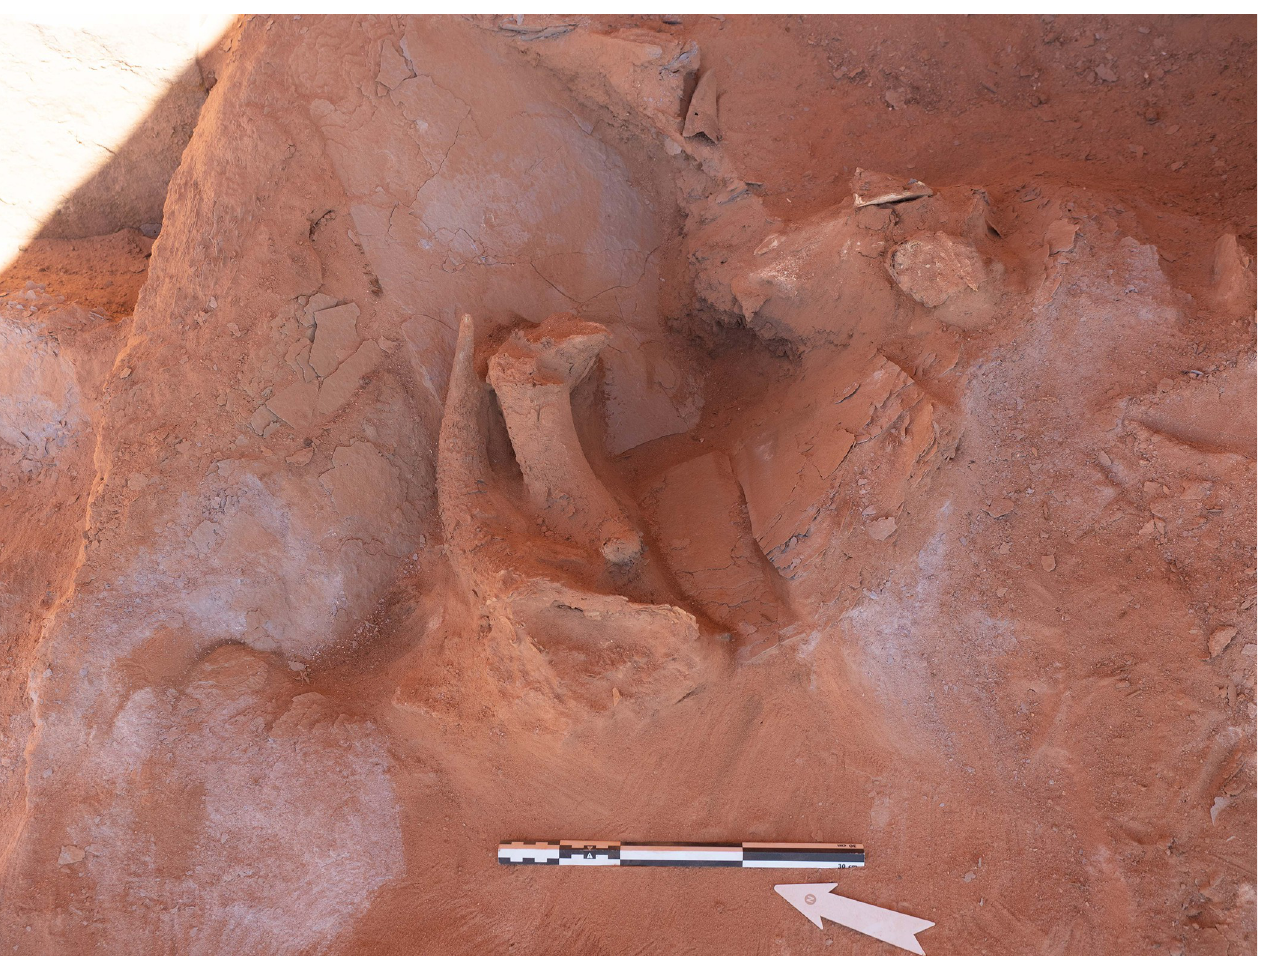
Fig 13. Horns found on a collapsed “bench” in Phase 4B. Left to right, large cattle horns/sheaths (#0043) and (#0033), goat horn sheath (#0047), goat (#0041), and cattle horn